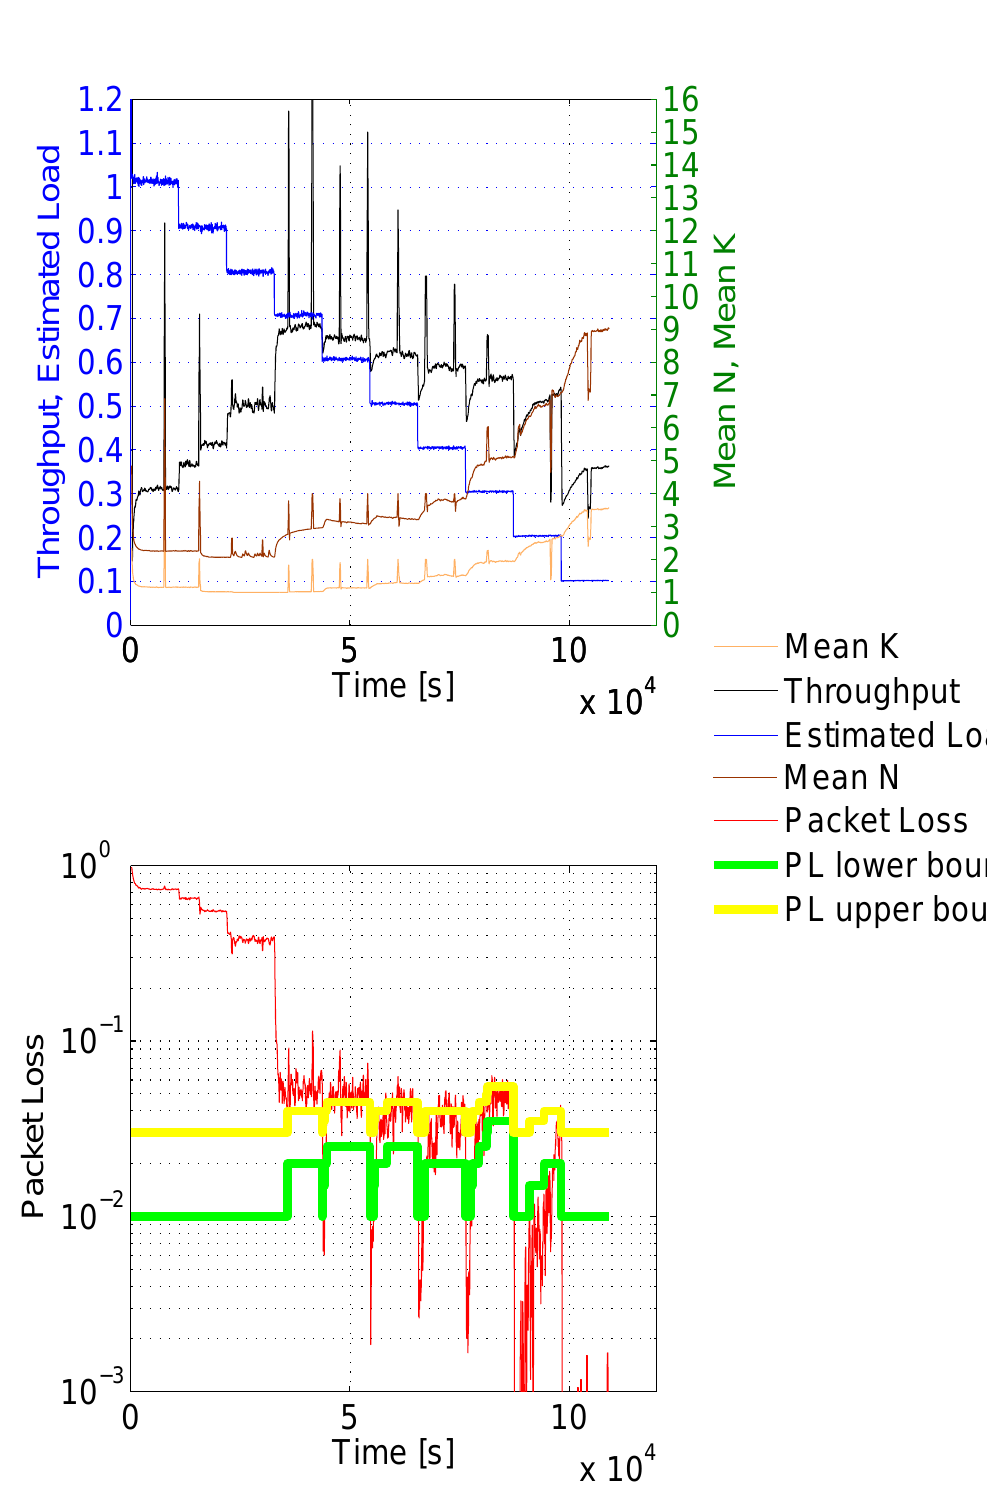
Figure 6. Throughput and Packet Loss for LC algorithm, linear code set C as in Table ??